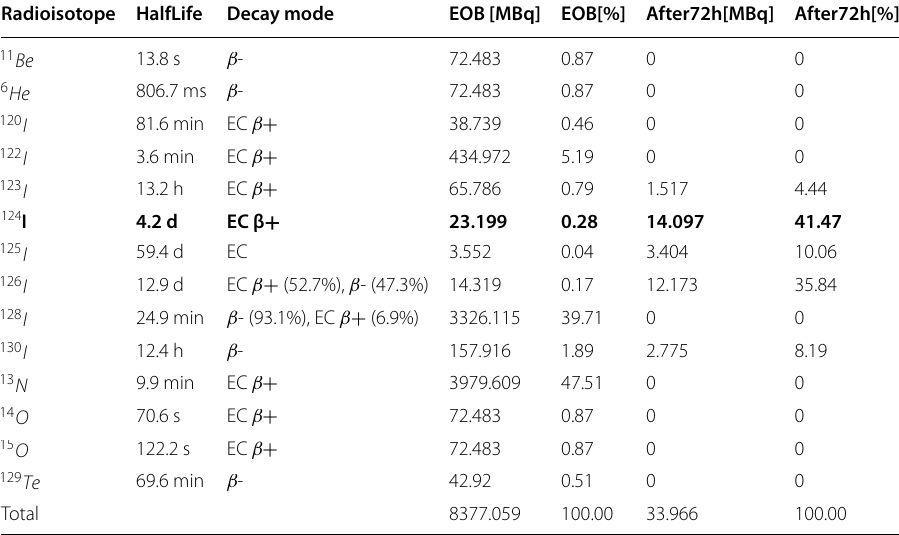
The production parameters: natural TeO 2 , 18 MeV protons moderated to 14.8 MeV with 0.2 mm Havar, the proton current of 10 μA. The activity values at the end of bombardment (EOB) and the activity values after 72 hours since the end of bombardment are presented. 124 I is highlighted in bold